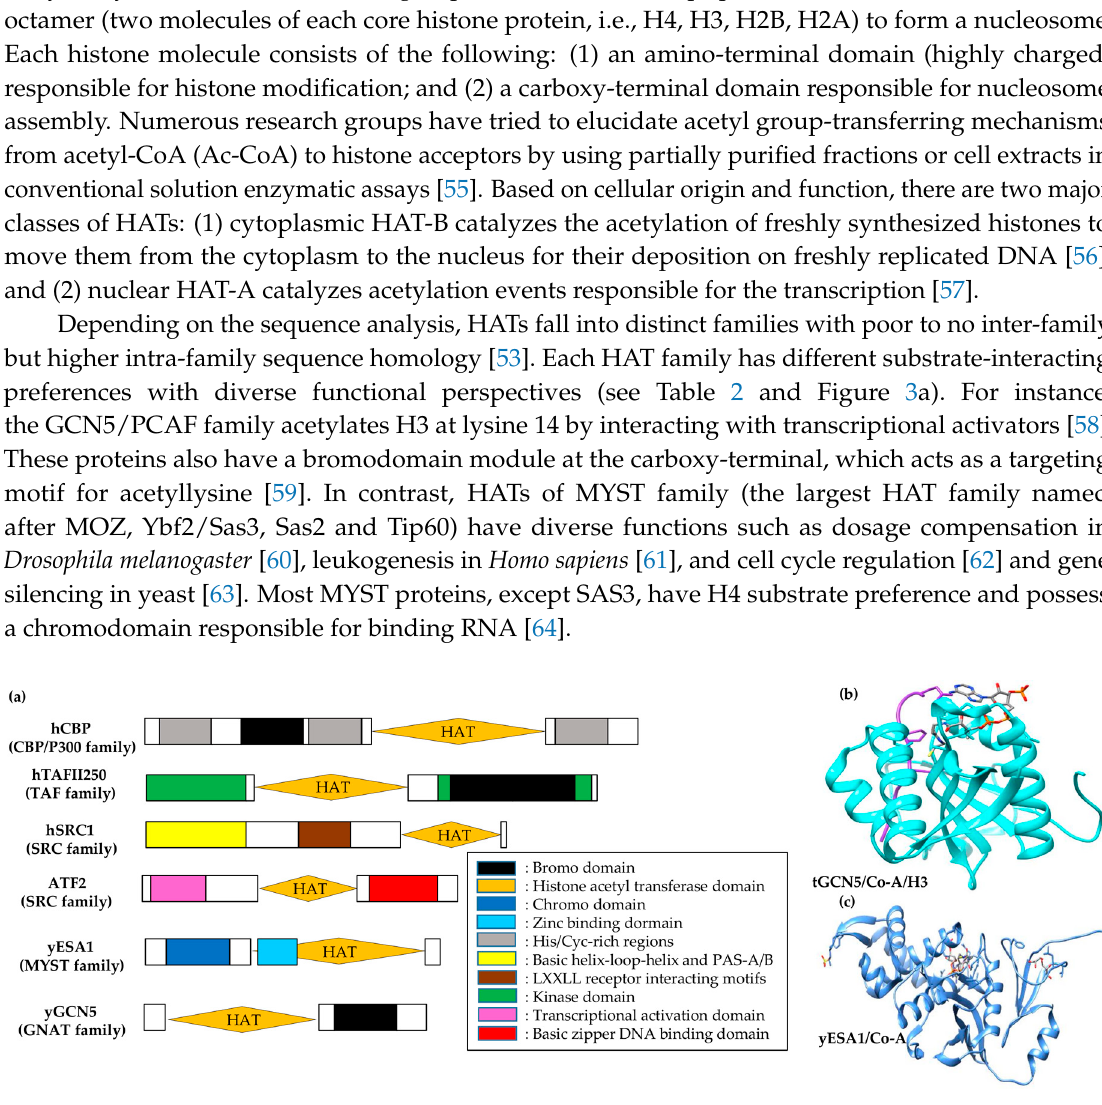
Figure 3. Histone acetyltransferase (HAT) families and complexes. ( a ) Bar diagram of different HAT family members (family name in parentheses) with their associated domains; ( b ) tGCN5/Co-A/histone H3 complex: cyan = tGCN5, purple = histone H3 peptide; ( c ) yESA1/Co-A complex: cornflower blue = yESA1, elemental structure = Co-A.